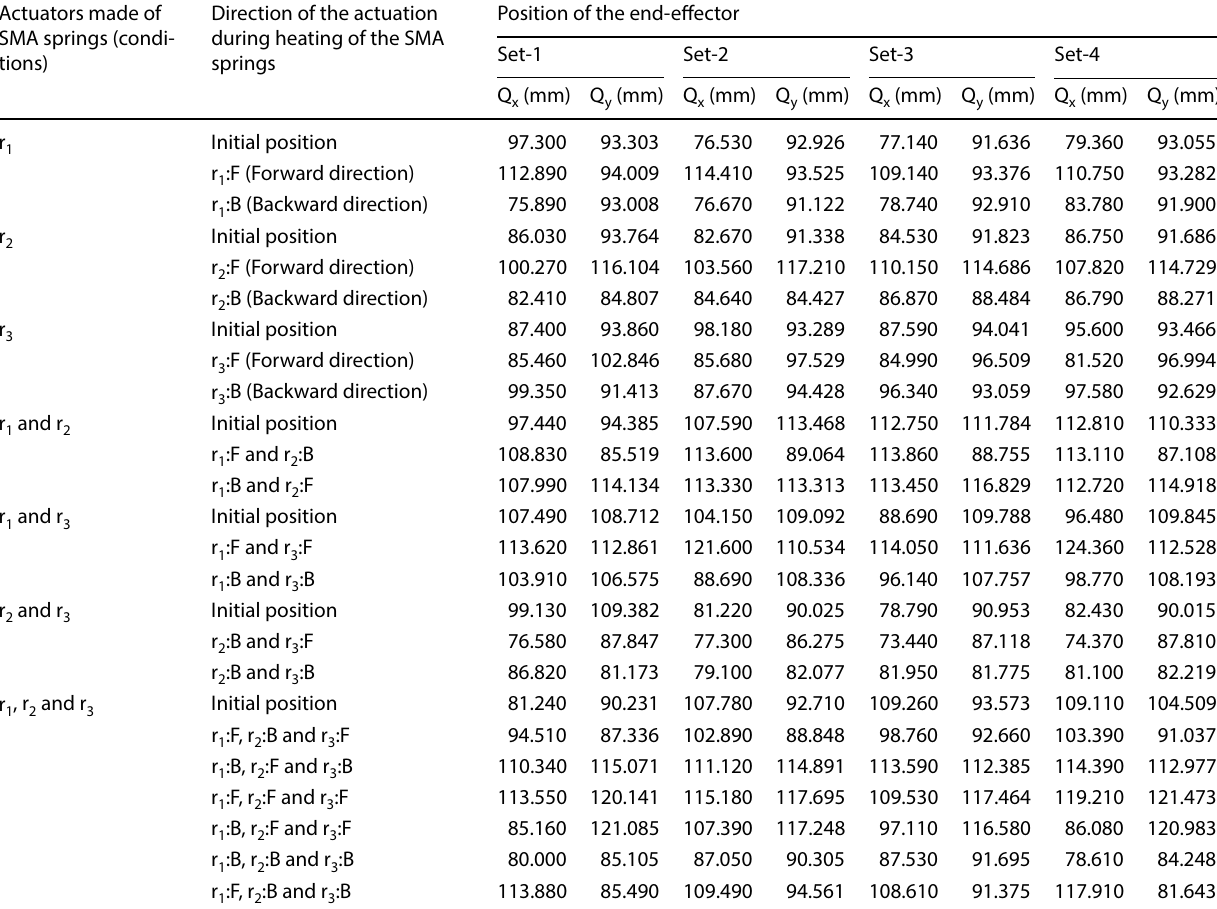
Direction of the actuation during heating of the SMA